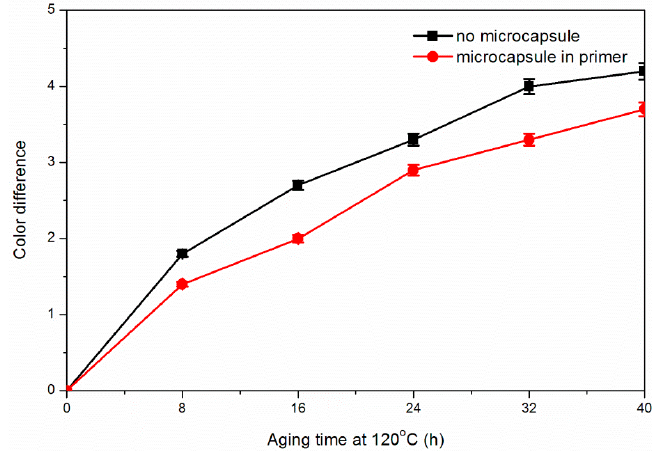
Figure 6. E ff ect of aging time on color di ff erence of the paint film in the 120 ◦ C Figure 6. Effect of aging time on color difference of the paint film in the 120 °C oven.